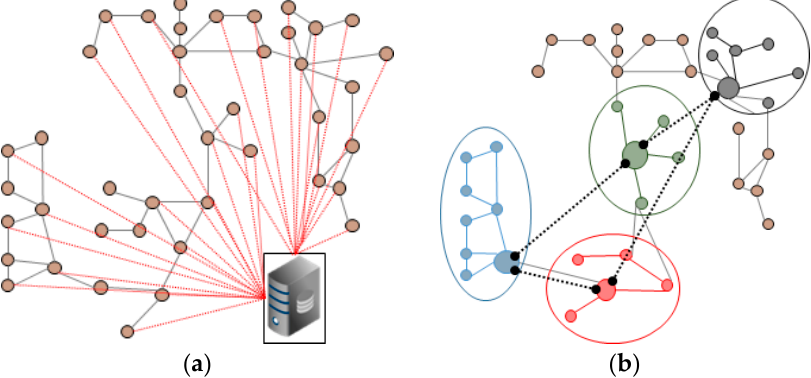
Figure 1. Traffic flow in a centralized platform and the self-organizing distributed platform. ( a ) Centralized Platform; ( b ) Self-Organizing Distributed Platform.